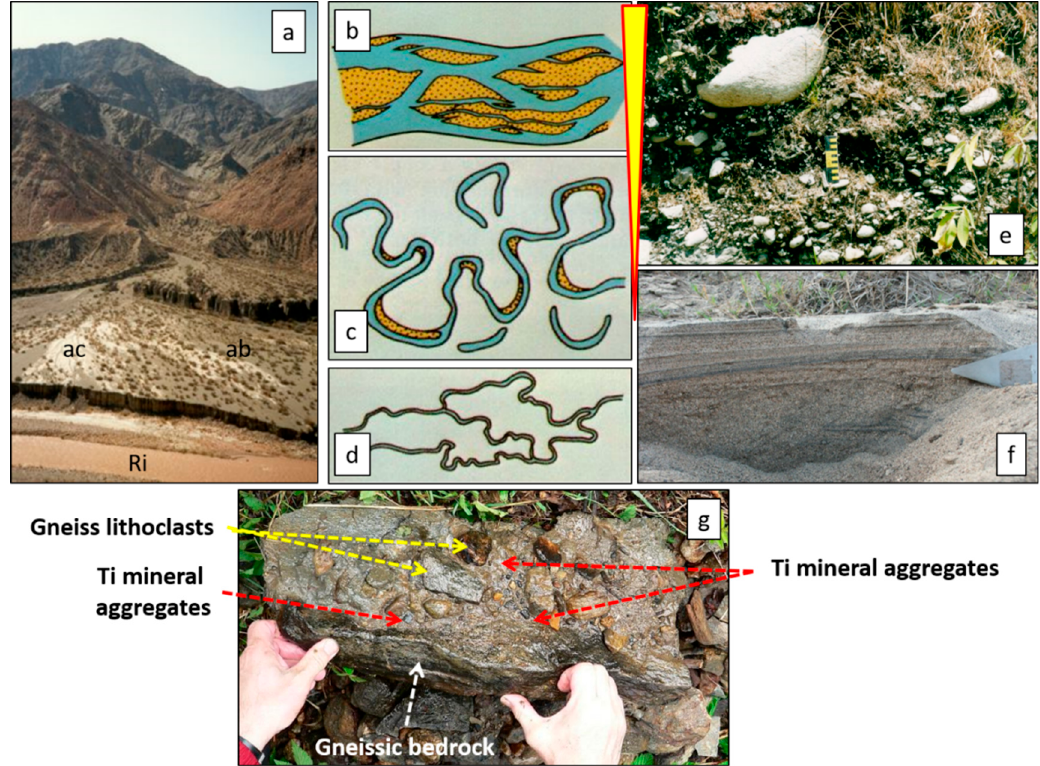
Figure 4. Alluvial-fluvial placers. ( a ) Scarcely to non-vegetated alluvial fans debouching into a periodically flooded more or less straight drainage system. The basement rocks are Permo- Carboniferous in age, the fan system has been developing since the Pleistocene (San Juan Valley, Argentina). Ri: active braided trunk river system, ac: active channels, and ab: abandoned channels. There are at least two stages of fan evolution. ( b ) Braided river system with the sandy bars in yellow. ( c ) Meandering river system with the sandy bars in yellow. Sand bars developed in the active channels at the point bars of the meander bows while the oxbow lakes and abandoned isolated meander belts filled with fine-grained clastic and organic sediment. ( d ) Anastomosing river system with almost no sand bars. The vertical wedge-shaped pattern denotes a decreasing-downstream concentration of heavy minerals by alluvial-fluvial processes. ( e ) Active channel system in the Ganesh Himal, Nepal, with rounded mega-clasts at the boundary between alluvial fans and braided rivers. Imbrication denotes flow direction from left to right. It is the environment most prospective for gemstone placers (in this tourmaline and garnet). ( f ) Black sands (fluvial placers of pyroxene and magnetite) underscore the sedimentary bedding textures in a tributary of the Shire River, Malawi. Sands with distorted bedding in a whirlpool overlain by sands characterized by antidunes. ( g ) Channel lag deposits forming the lowermost concentration of heavy minerals and aggregated immediately on top of the bedrock of the braided streams (Pleystein, SE Germany). In this case the fluvial placer is composed mainly of “nigrine” (rutile-ilmenite intergrowth).